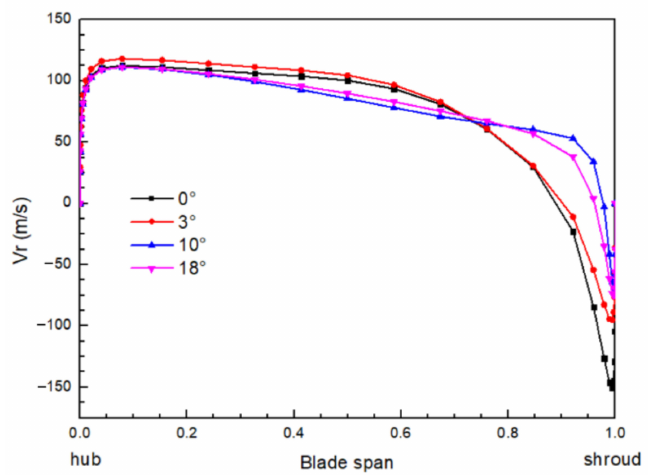
Figure 16. Pitch-wise distribution of radial velocity at diffuser inlet.